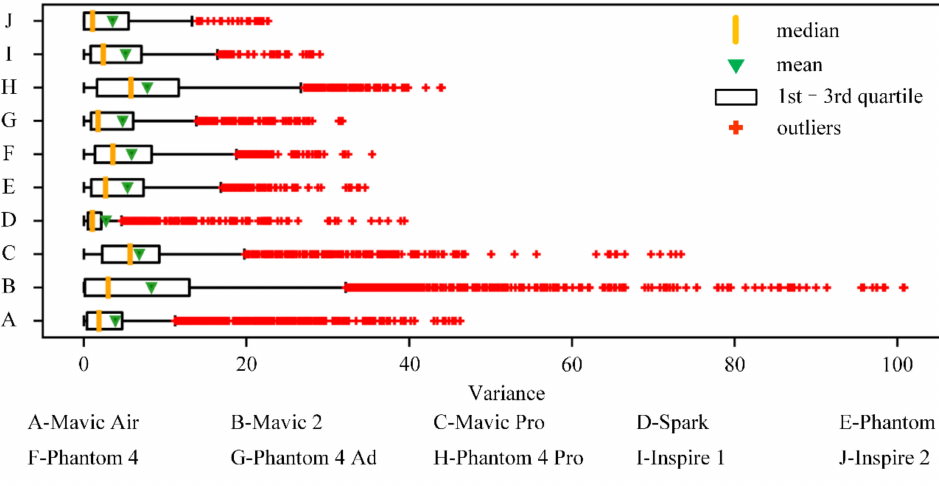
Figure 4. Distribution of the change of GS for each type of quadrotor.